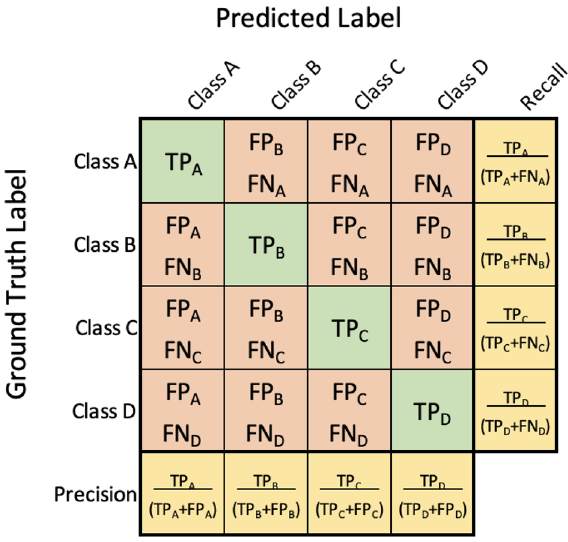
Figure 3. Confusion matrix template for a generic multi-class classification problem, showing how precision and recall are calculated for each class.